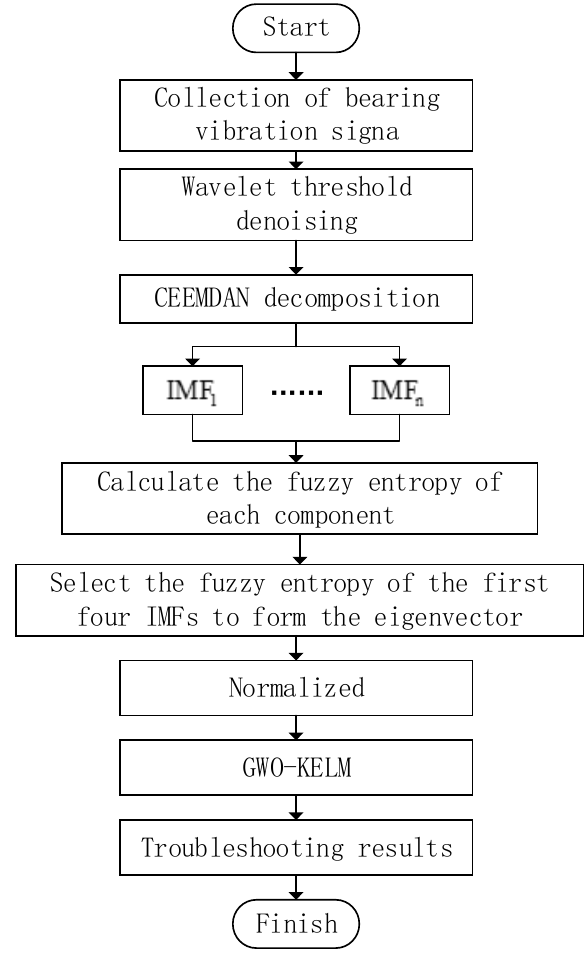
Figure 4. The overall fault diagnosis flowchart.